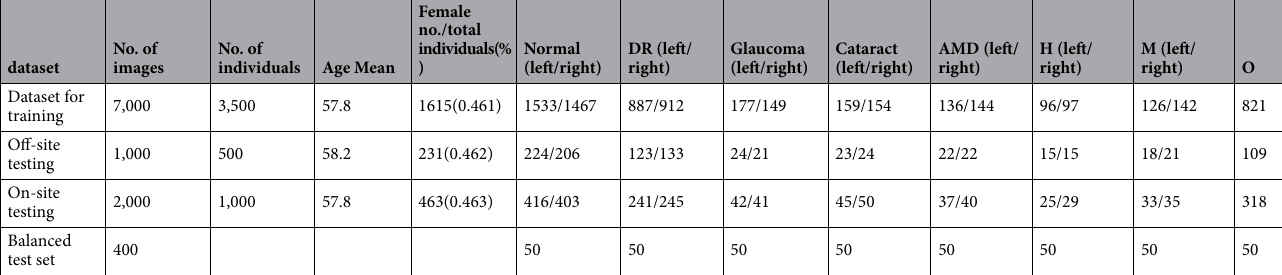
Table 8. Dataset